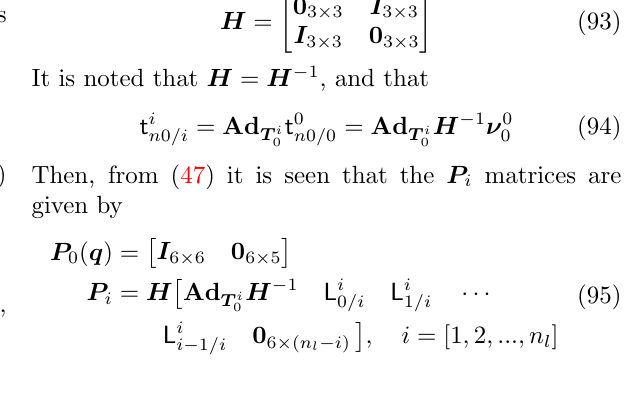
Figure 2: Frames { n } and { i } where i = 0 , . . . , 5. coordinates of the origin of frame { i } relative to the ori- gin of frame { i − 1 } . In the Denavit-Hartenberg con- vention this is described as a composite displacement of a rotation θ i about the z i − 1 axis, a translation d i along the same axis, a rotation α i about the x i axis followed by a translation a i along the same axis. Note that θ i is the joint variable, while the parameters d i , α i and a i describe the geometry of the link transformation. This gives a homogeneous transformation matrix